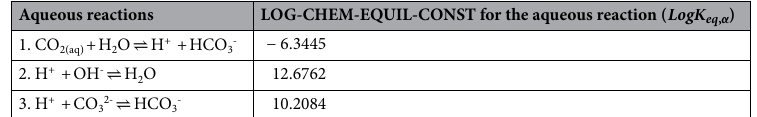
Table 2. Aqueous reactions with their LOG chemical equilibrium constants.